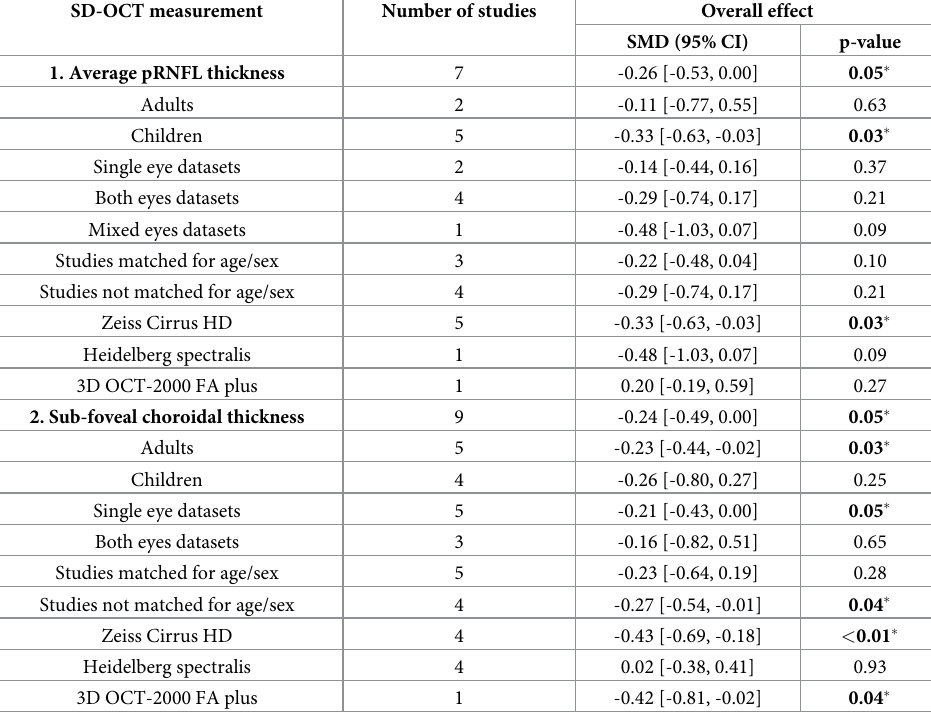
Table 4. Detailed results of sub-group analyses for the average pRNFL thickness and sub-foveal choroidal